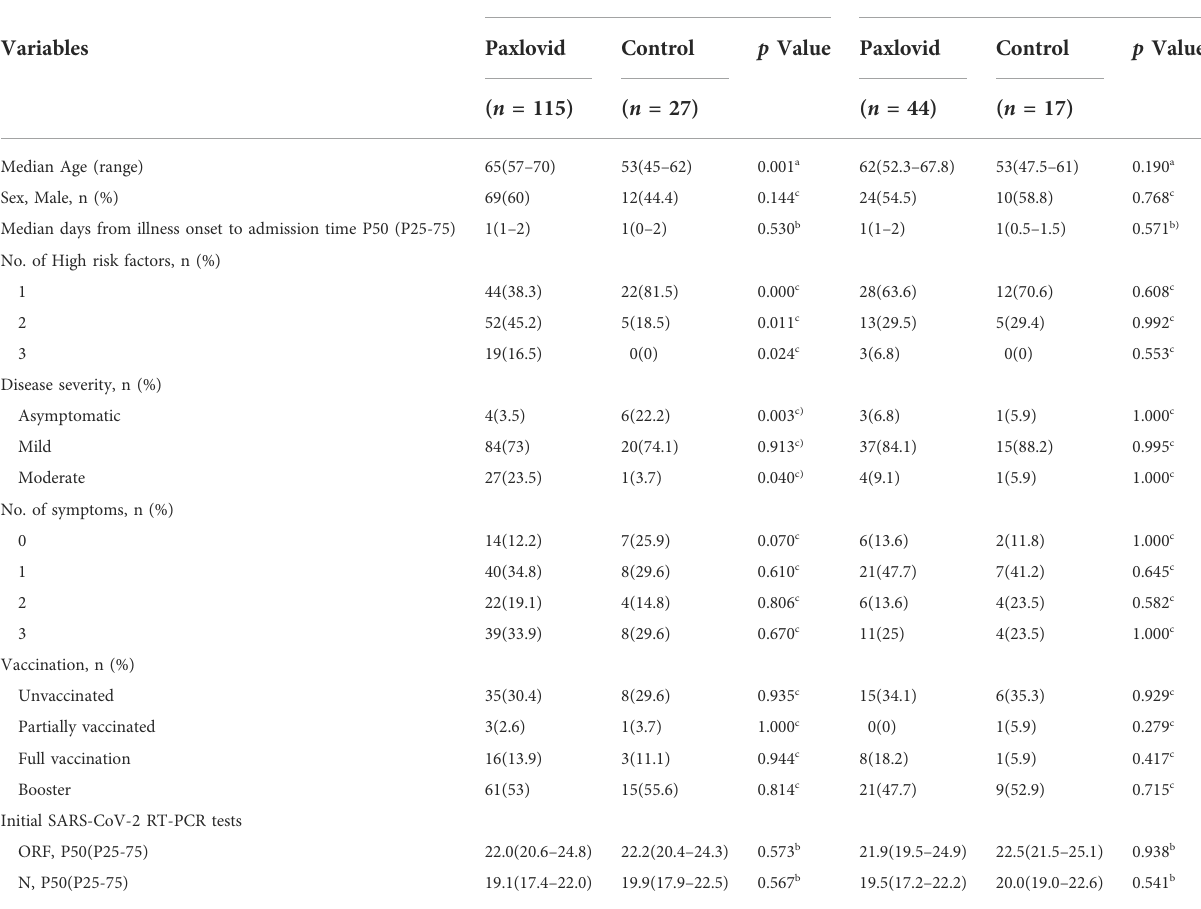
TABLE 4 Baseline characteristics of COVID-19 patients before and after propensity score matching between Paxlovid and control group. Before propensity score matching After propensity score